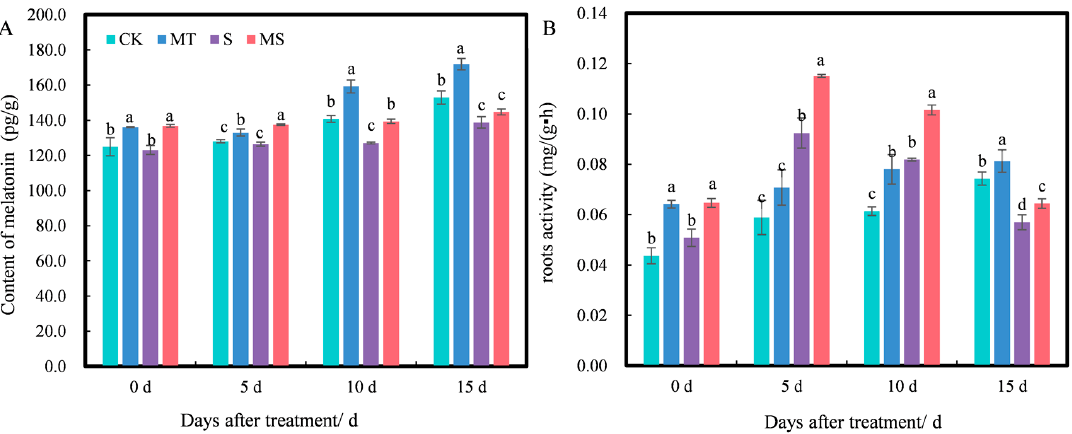
Figure 6. Effects of exogenous melatonin on ( A ) endogenous melatonin contents and ( B ) root activity of cotton seedling roots under salt stress. Different lowercase letters indicate significant differences among treatments at each timepoint ( p < 0.05). CK, control treatment; MT, melatonin treatment; S, NaCl treatment; MS, combined melatonin and NaCl treatment.